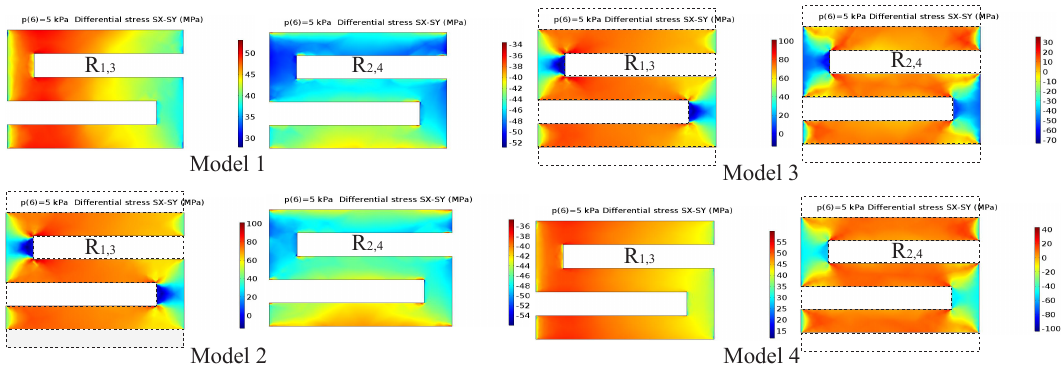
Figure 8. Differential stress distributions in the piezoresistors of sensor designs under a pressure loading of 5 kPa.